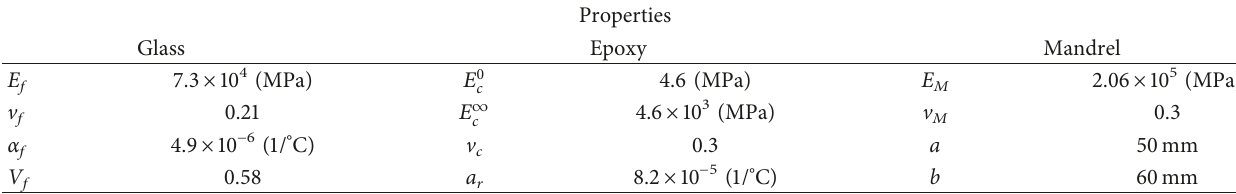
Table 1: Fiber and resin mechanical properties. Properties